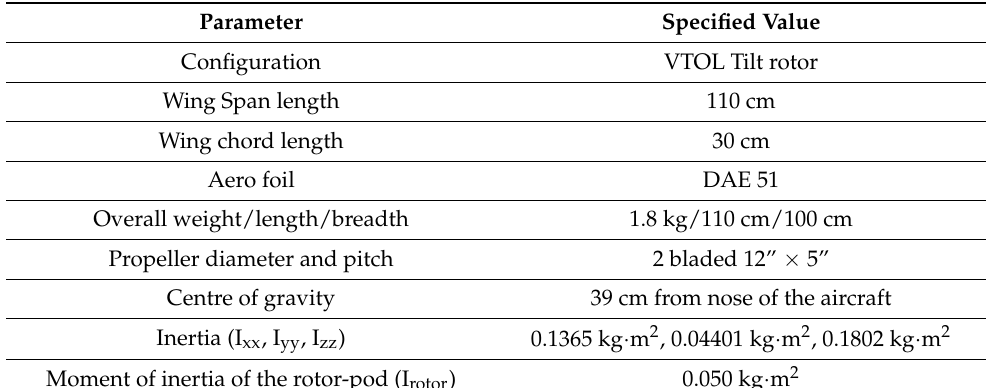
Table 1. Mechanical design parameters